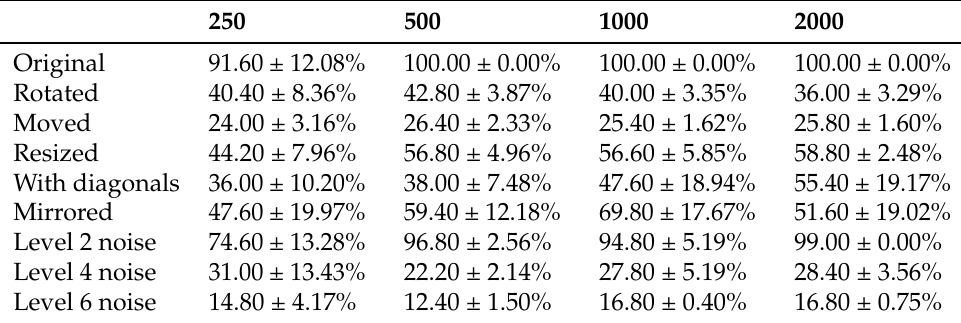
Table 1. Training set: Original objects; Test set: Transformed